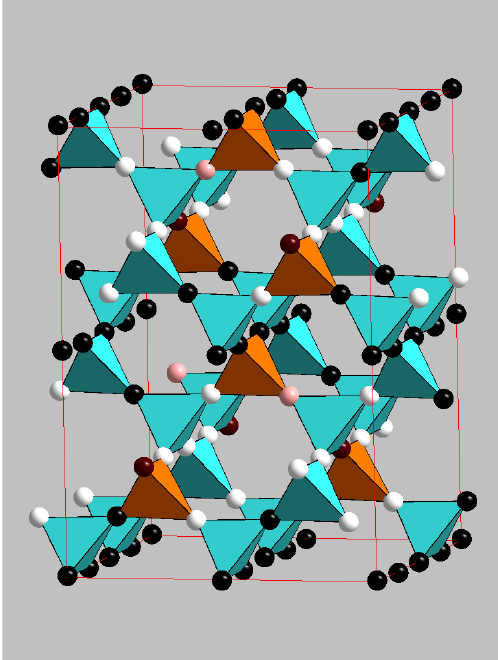
Figure 1. Sketch of the Cc cell of magnetite below the Verwey transition. Shown is the iron charge order on the B sites, with the Fe valences in ionic approximation indicated by dark (Fe 2 + ) and bright (Fe 3 + ) shading (A site Fe and O sites are omitted). Fe sites which have the opposite valence in the centrosymmetric P 2/ c model are hued in red. Tetrahedra with “3:1” configuration are colored cyan, those with “2:2” configuration orange. Replotted after Reference